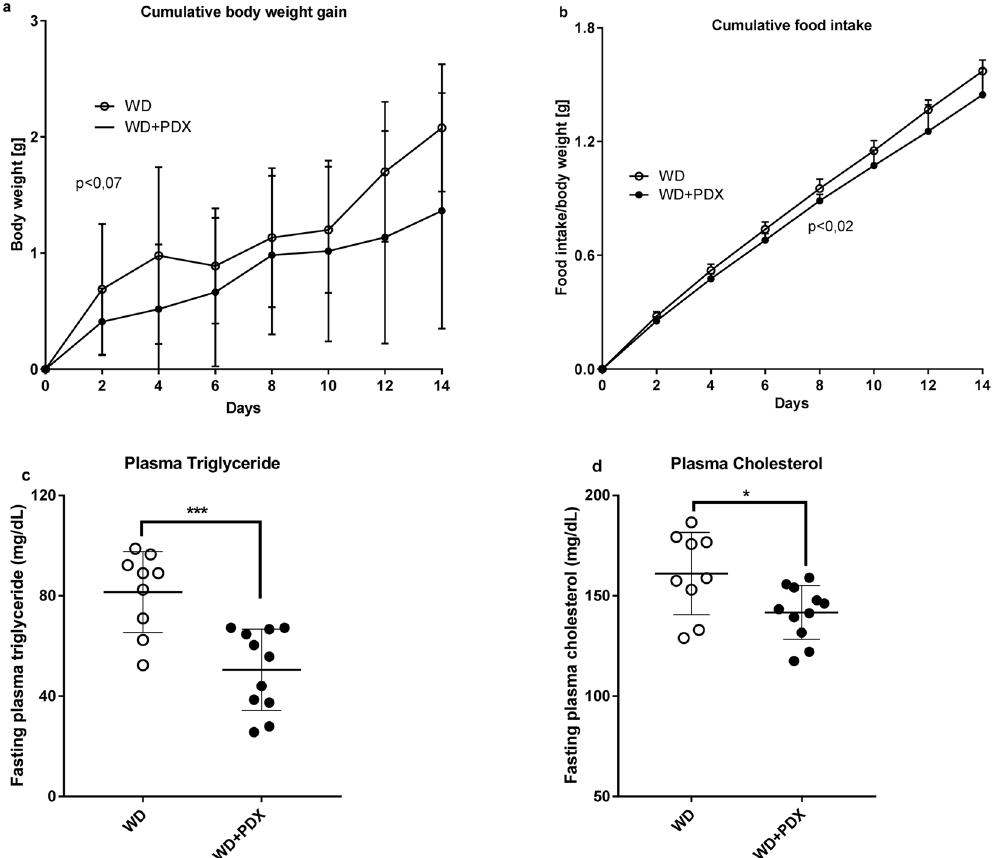
Figure 1. Body weight gain ( a ), Cumulative food intake ( b ), fasting plasma triglyceride and cholesterol ( c and d ). WD; Western diet fed mice, WD + PDX; Western diet fed mice that received PDX 75 mg twice daily for 14 days. The values are presented as mean ± SD. p < 0.05 was considered as statistical significance. * p ≤ 0.05, ** p ≤ 0.01, *** p ≤